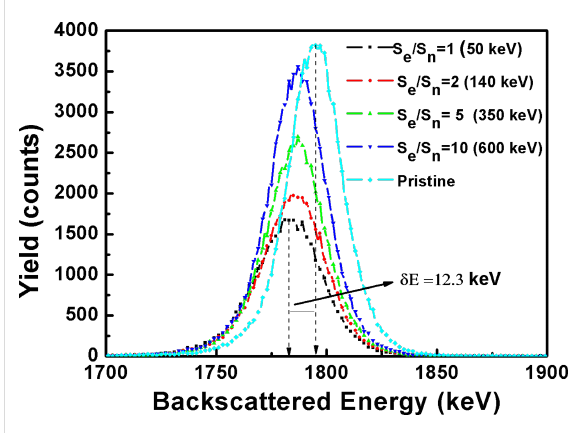
Figure 3: Rutherford backscattering spectra of the pristine and the irradiated films (Pt–Si).